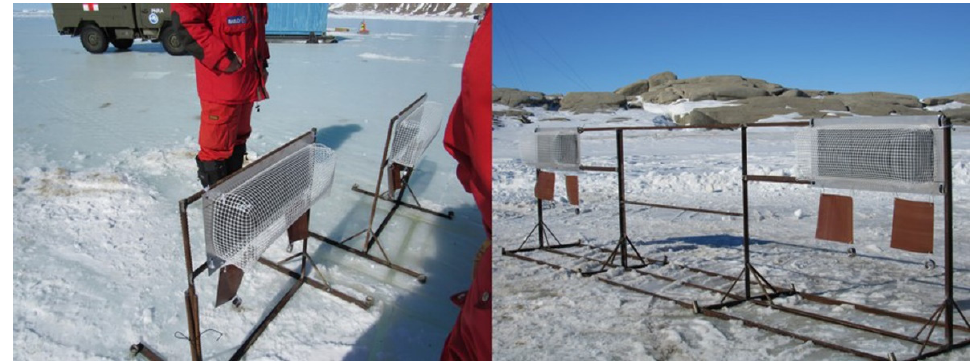
Figure 2. Artificial structures on which the three polyvinyl chloride (PVC) panels (covered with a net for protection) and two polyethylene (PE) sheets were installed. After panel recovery, any biofilm was removed by delicate scraping with a sterile scalpel from a surface equal to 6 × 18 cm of the PVC and PE panels deployed at 5 m and 20 m depths. Removal by scraping is a method commonly adopted to detach aquatic